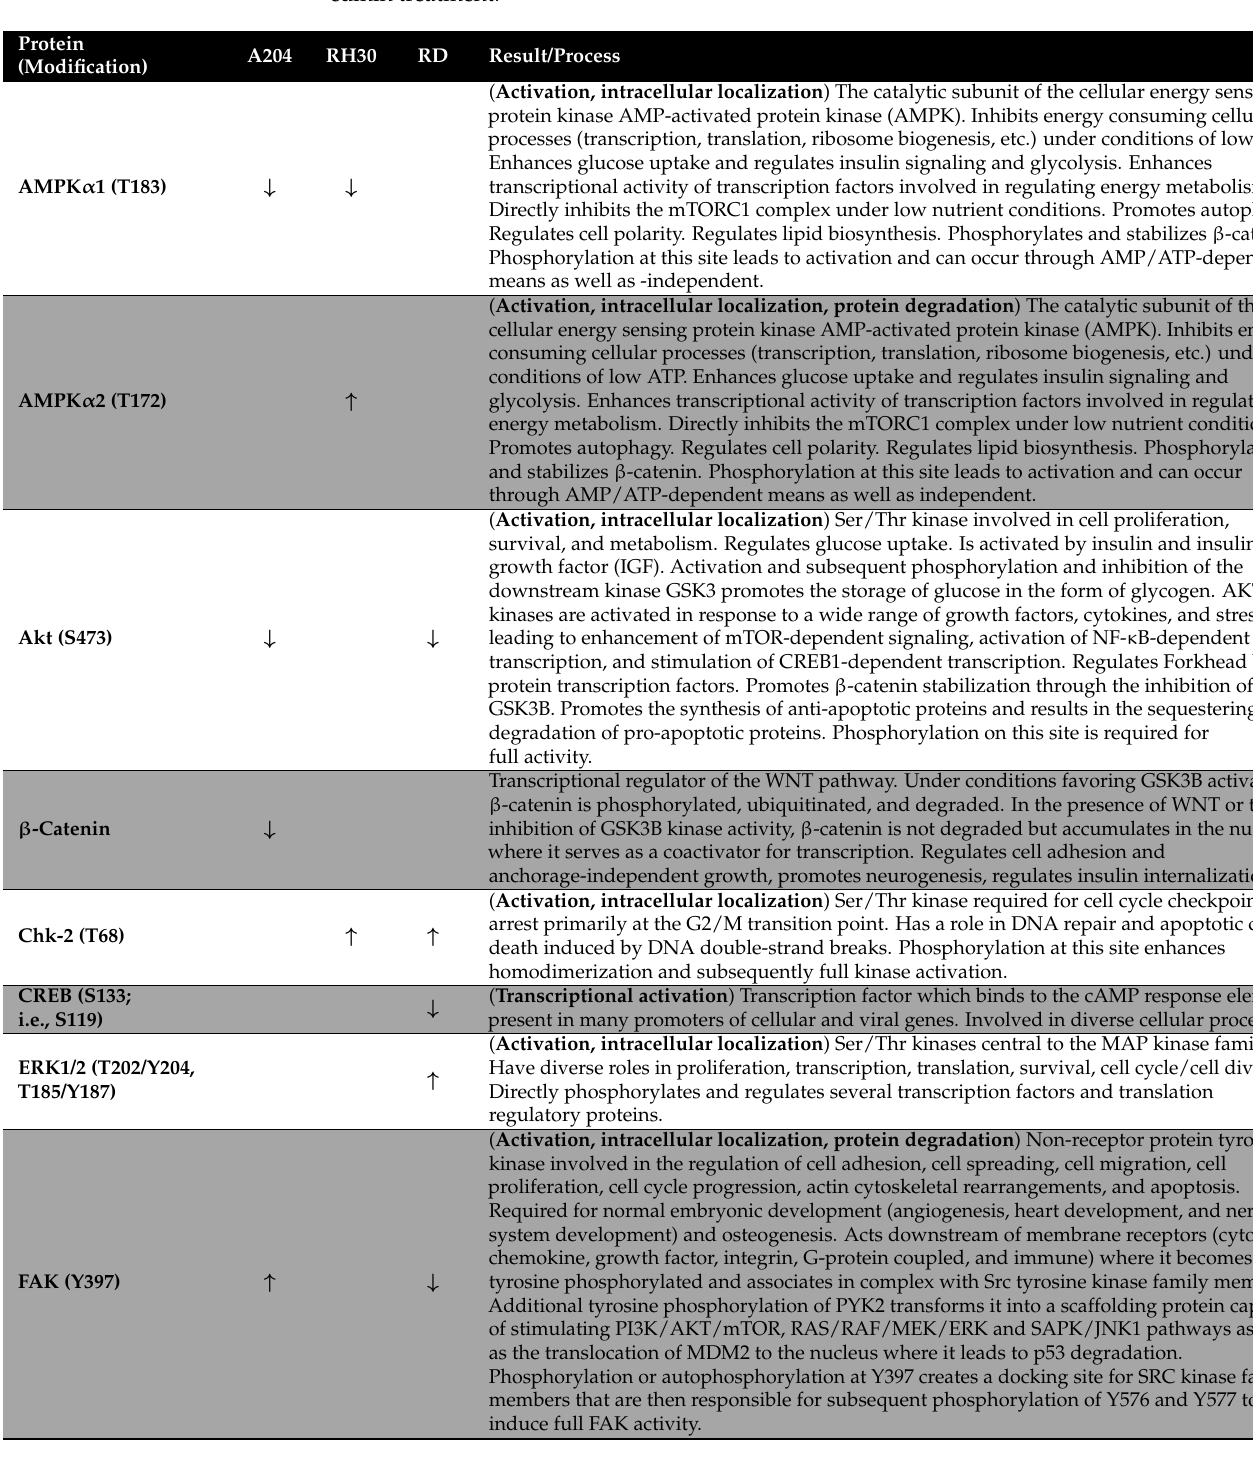
Table 1. Changes in signal transduction mediators observed in RMS cell lines following cur- cumin